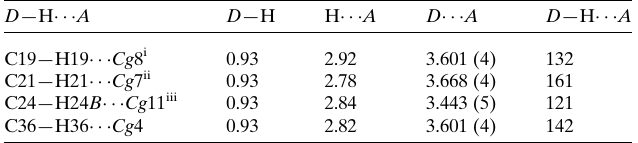
Table 1 Hydrogen-bond geometry (A˚ , (cid:3) ).